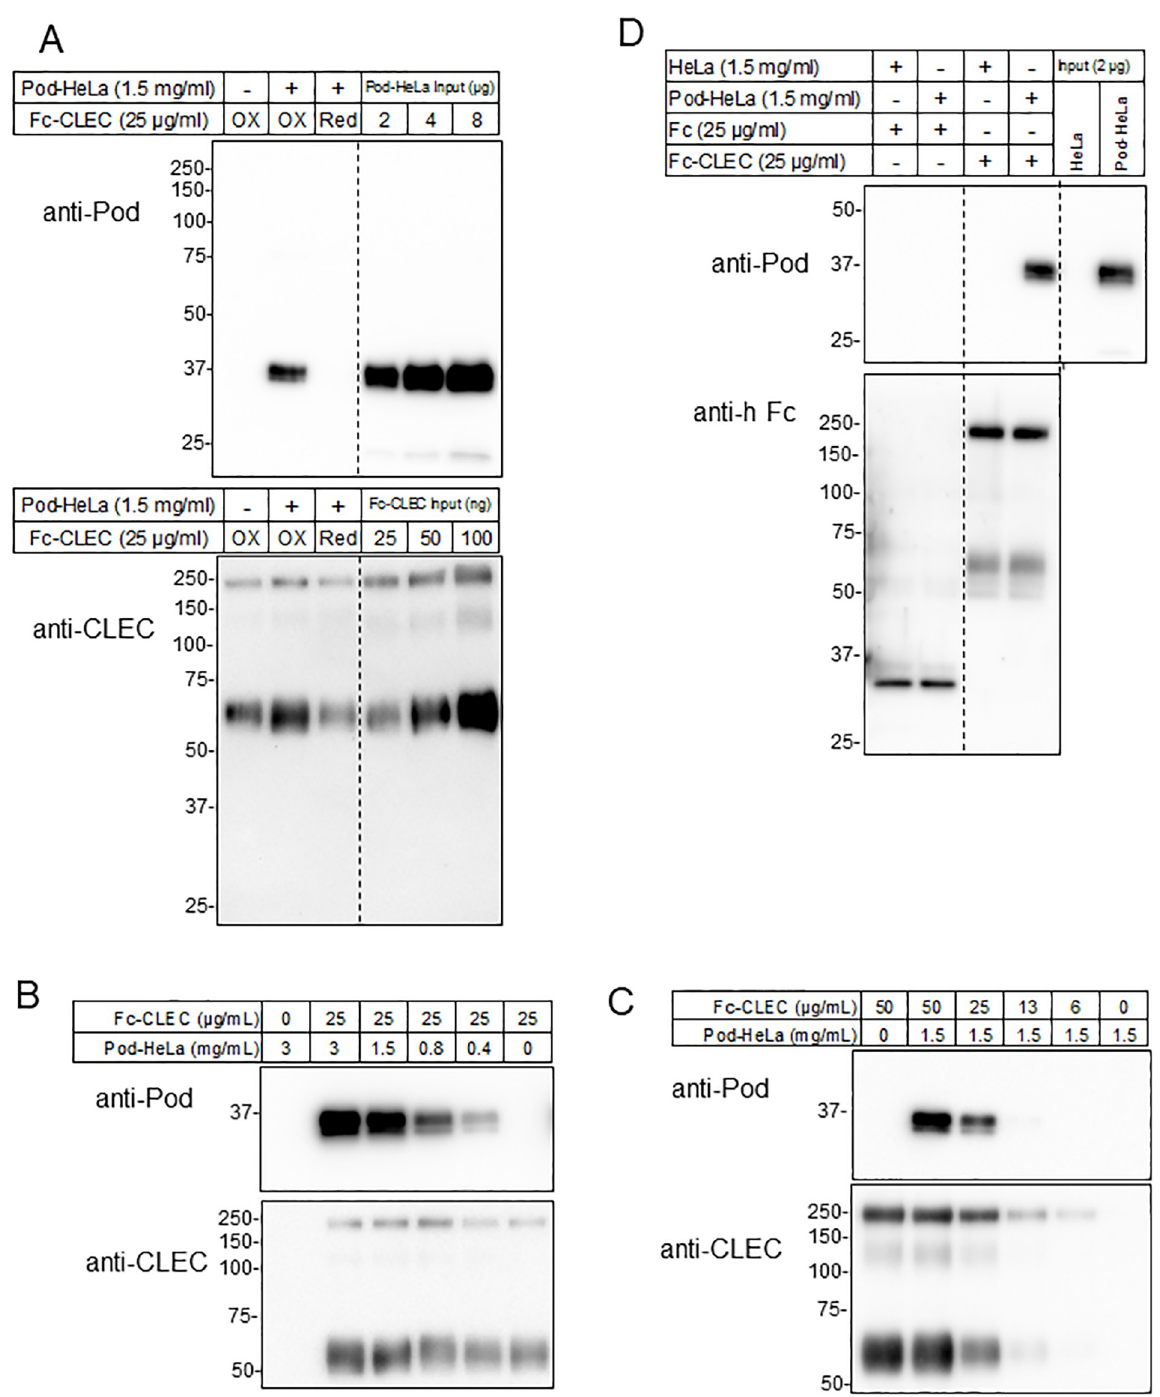
Fig 3. Binding of Fc-CLEC-2 to podoplanin in pod-HeLa cell lysates. (A) Effect of prior reduction of Fc-CLEC-2 disulfide bonds with DTT on its binding to podoplanin. Purified Fc-CLEC-2 in PBS was untreated or treated with 10 mM DTT for 5 h at room temperature. The binding reaction with podoplanin was then performed at final concentrations of 1.5 mg/mL and 25 μ g/mL for pod-HeLa lysate and Fc-CLEC-2, respectively. Acid-elution fractions were analyzed by western blotting under reducing conditions using anti-podoplanin (upper blot) or anti- CLEC-2 (lower blot). The indicated amounts of pod-HeLa lysate or Fc-CLEC-2 were also loaded (Input). If the recovery of the pull-down assay is 100%, the maximum amount of podoplanin on the blot corresponds to 8 μ g of pod-HeLa lysate and the maximum amount of Fc-CLEC is 65 ng. ‘Ox’ and ‘Red’ represent samples without and with DTT pre-treatment, respectively. (B and C) Western blot analysis of concentration- dependent formation of the podoplanin-Fc-CLEC-2 complex. Complexes were made by mixing the indicated concentrations of non-reduced Fc-CLEC-2 and pod-HeLa lysates. (D) Specificity of the pull-down reaction. Pull down assays were conducted with a combination of lysate from parental HeLa cells or pod-HeLa cells, each at 1.5 mg/mL, and Fc or Fc-CLEC, each at 25 μ g/mL, as noted on the above the blots. Acid-elution